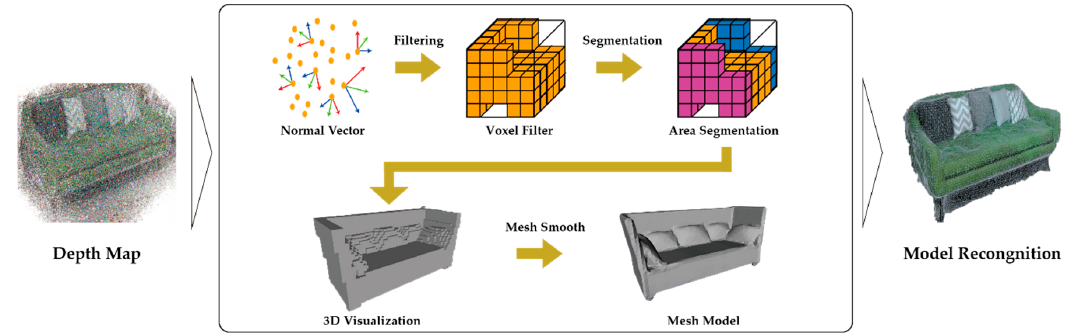
Figure 1. Model recognition pre-processing process.